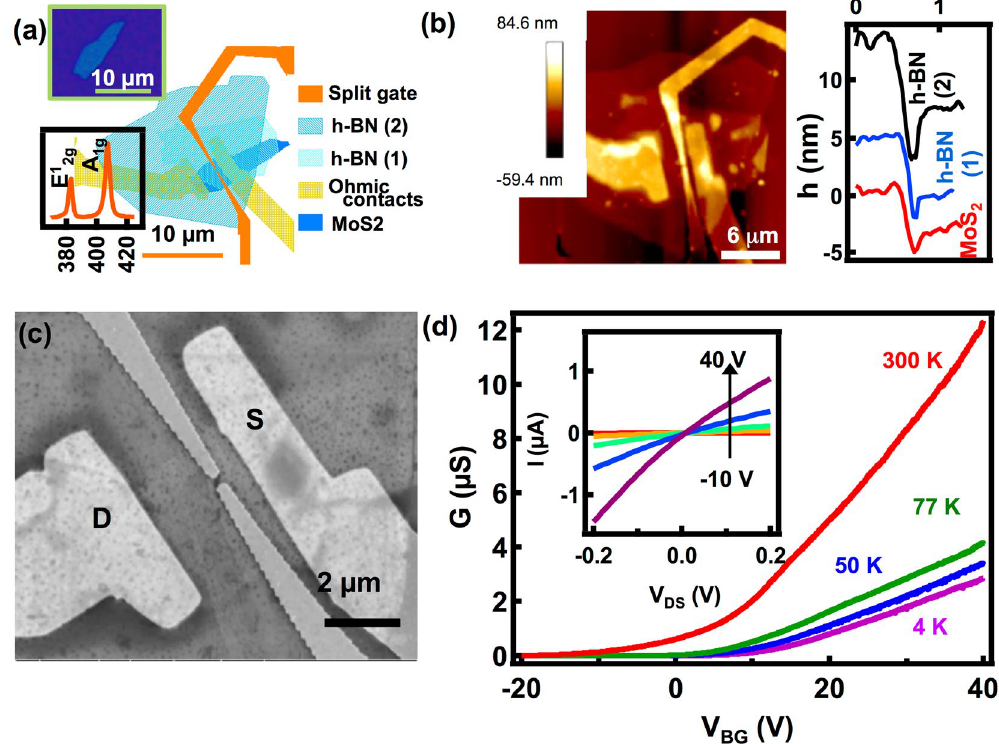
Figure 1. ( a ) A sketch of the device drawn to scale, with all the layers labelled. The top inset shows the optical image of the MoS 2 flake and the bottom inset shows the Raman spectra of the MoS 2 showing characteristic Raman peaks. ( b ) Left: AFM image of the device. Right: AFM height profiles of the MoS 2 , h-BN (1) and h-BN (2) flakes showing thickness of 3.5 nm, 5 nm and 6 nm respectively. ( c ) SEM image of the device showing the point-contact with a lithographic length of 280 nm and width 220 nm. The drain and source contacts are